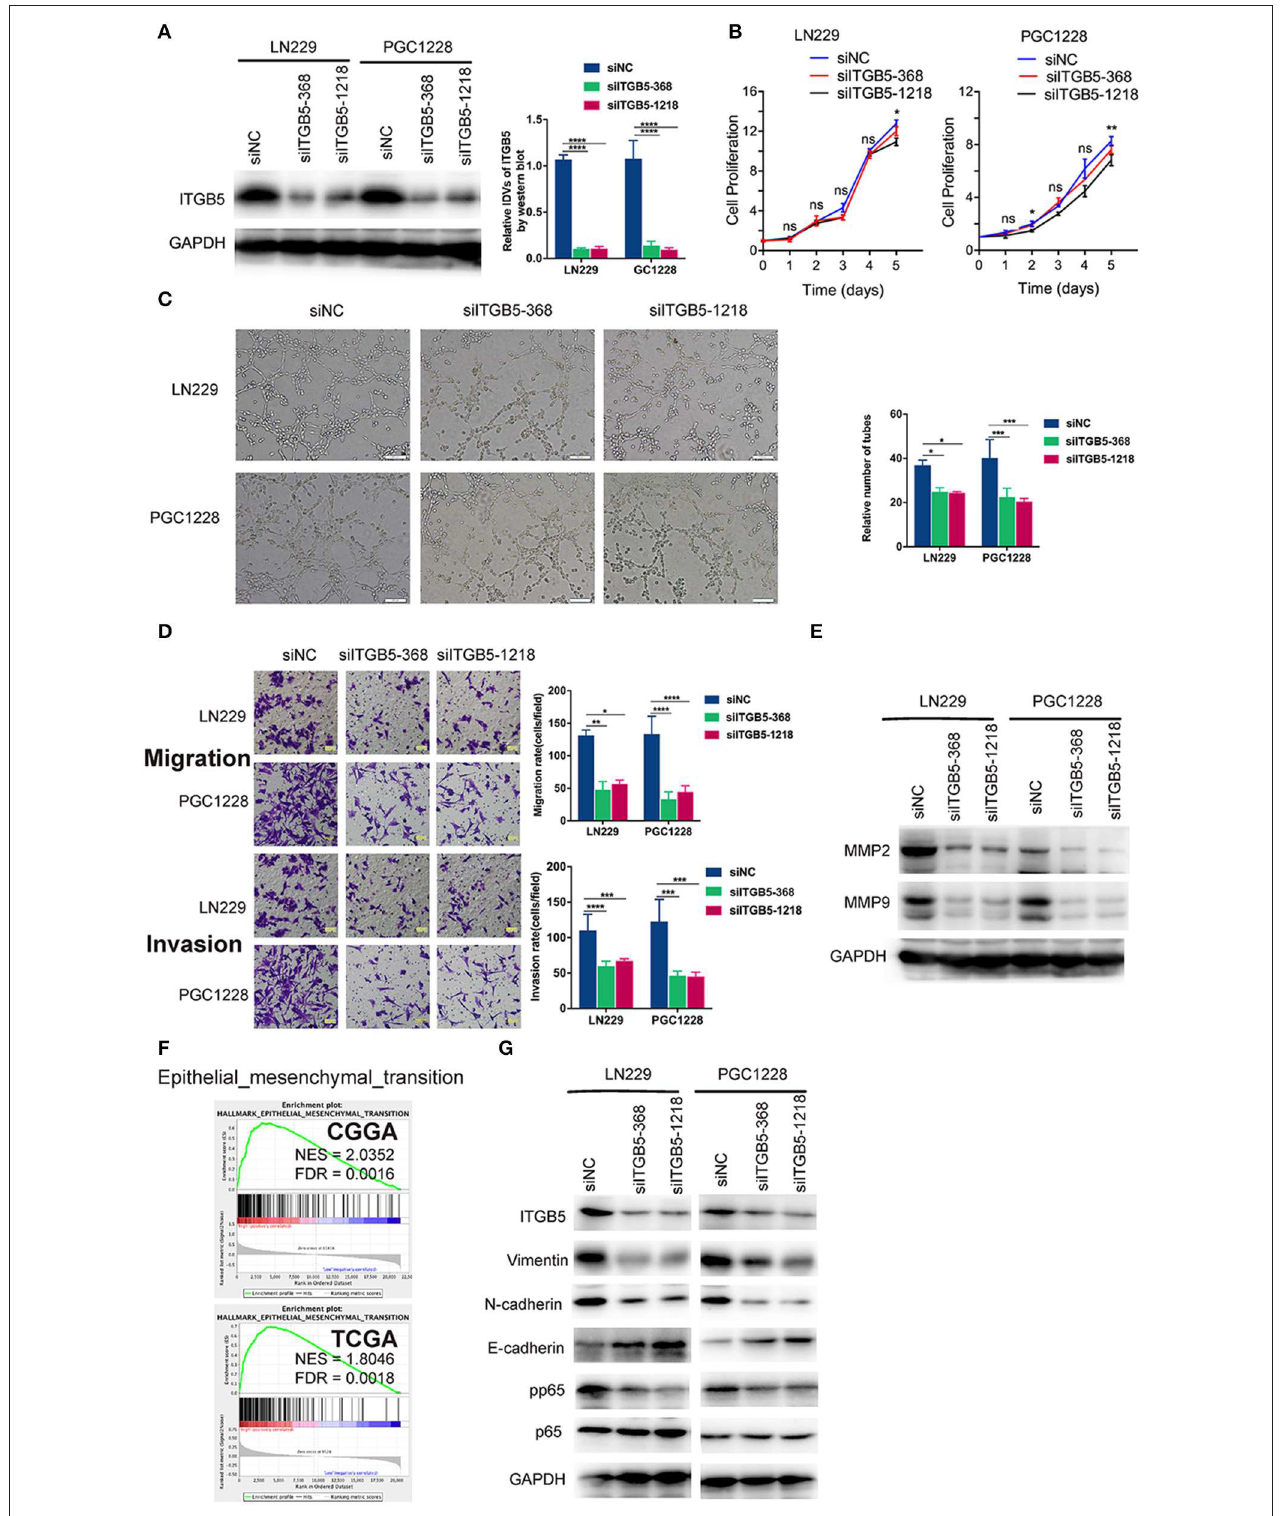
FIGURE 5 | ITGB5 silencing attenuates the migration and angiogenesis of glioma cells and inhibits epithelial-mesenchymal transition marker expression. (A) Representative western blots (left panel) and analysis (right panel) of glioma cells transfected with indicated siRNAs targeting ITGB5 (si ITGB5 -368 and si ITGB5